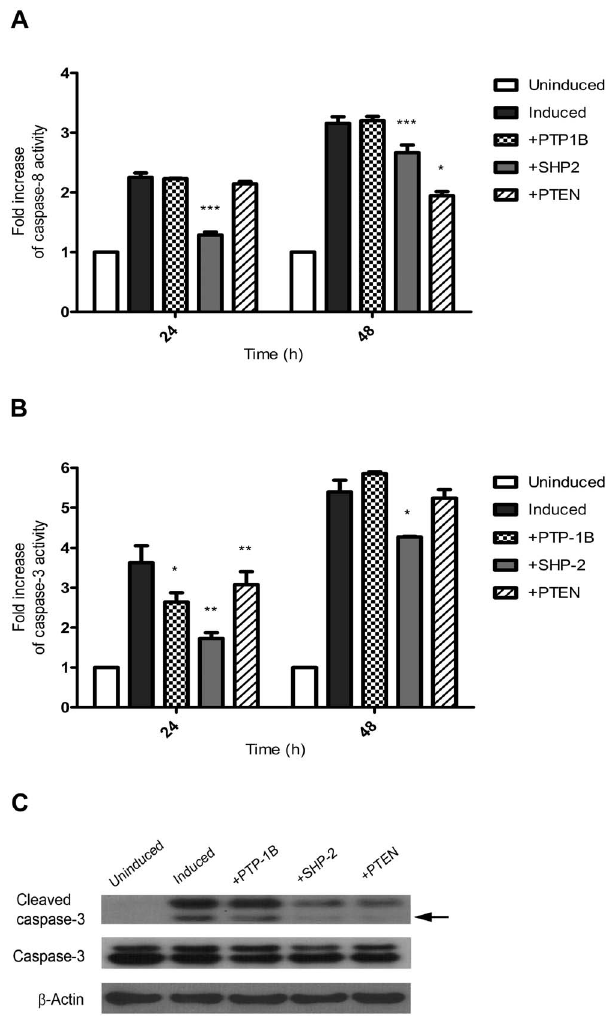
Figure 5. Knockdown of PTP expression leads to a reduction in caspase activity. ER-dnE2F1 cells were transfected with siRNA specific for PTP-1B ( + PTP-1B), SHP-2 ( + SHP-2), or PTEN ( + PTEN). Uninduced and induced control cells were transfected with scrambled siRNA. Then cells were treated with 4-OHT for 24 or 48 h to initiate Rb/E2F-associated apoptosis. Uninduced control cells were left untreated. (A) Caspase-3/ CPP32 cleavage was measured by colorimetric assay in three independent experiments. Results are expressed as the mean + standard error. (B) FLICE/Caspase-8 cleavage was measured by colorimetric assay in three independent experiments. Results are expressed as the mean + standard error. (C) Total protein was isolated from lysated cells at 24 h following induction of apoptosis, resolved by SDS-PAGE, and immunoblotted with antibodies specific for cleaved caspase-3 (Denoted by arrow), caspase-3 and b -actin. (*) p , 0.05; (**) p =0.01; (***) p , 0.01.